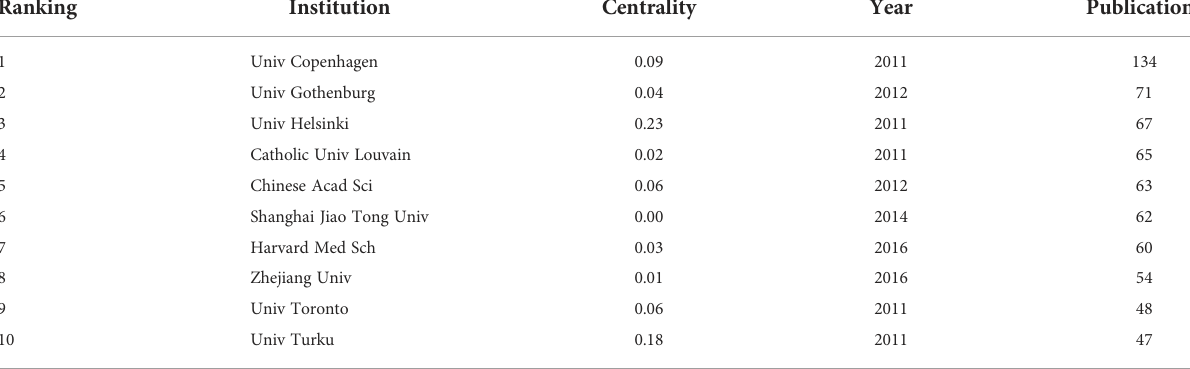
TABLE 2 Top 10 institutions contributing to the number of